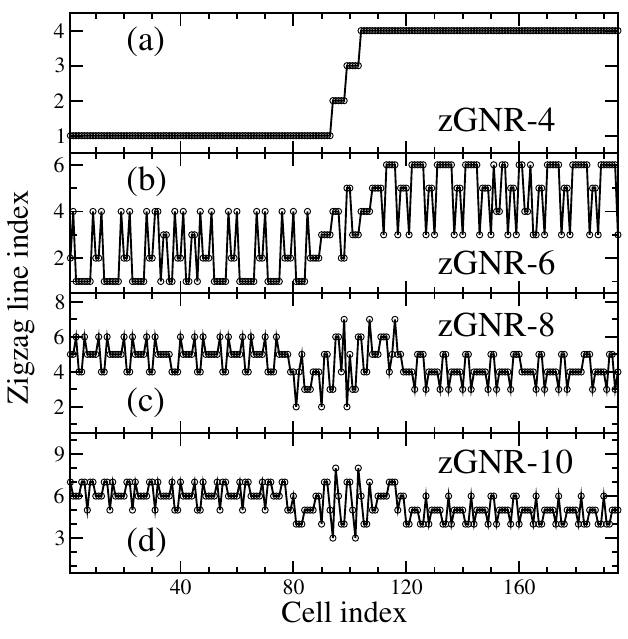
Figure 5. Index of the zigzag strip along the ribbon width presenting the largest inter-site current for each zGNR unit cell along the junction for the zGNR-4 ( a ), -6 ( b ), -8 ( c ) and -10 ( d ) systems in the heterospin